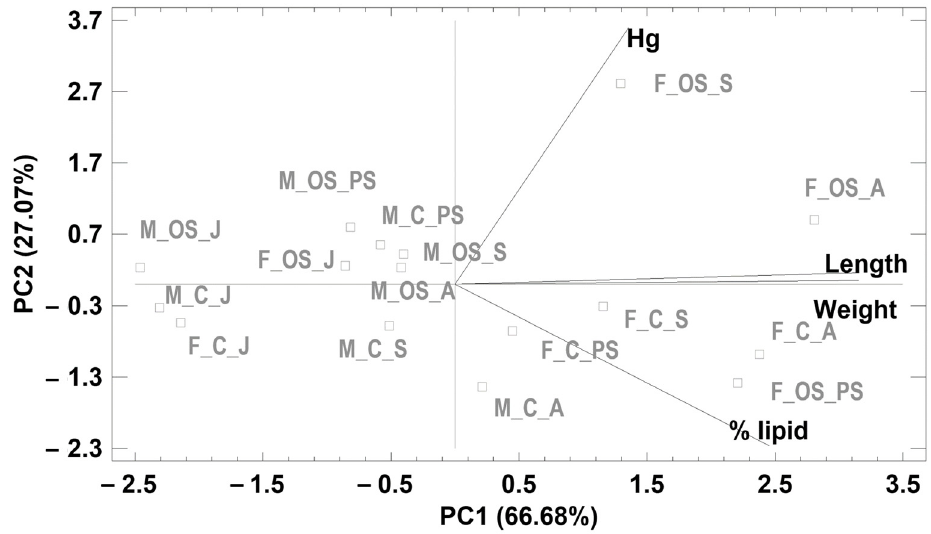
Figure 3. 2D biplot of PC1 vs. PC2. M: male; F: female; OS: open sea; C: coast; J: juvenile; A: adult; S: spawning; PS: post-spawning.